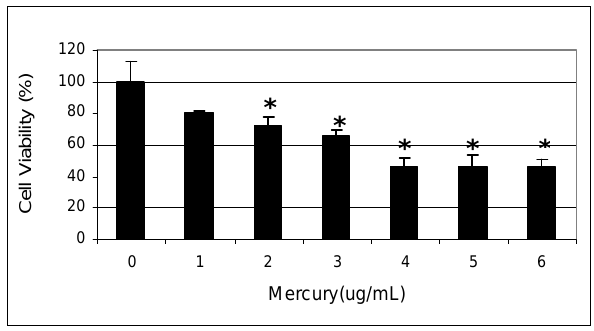
Figure 1: Cytotoxicity of mercury to human renal proximal tubule (HK-2)